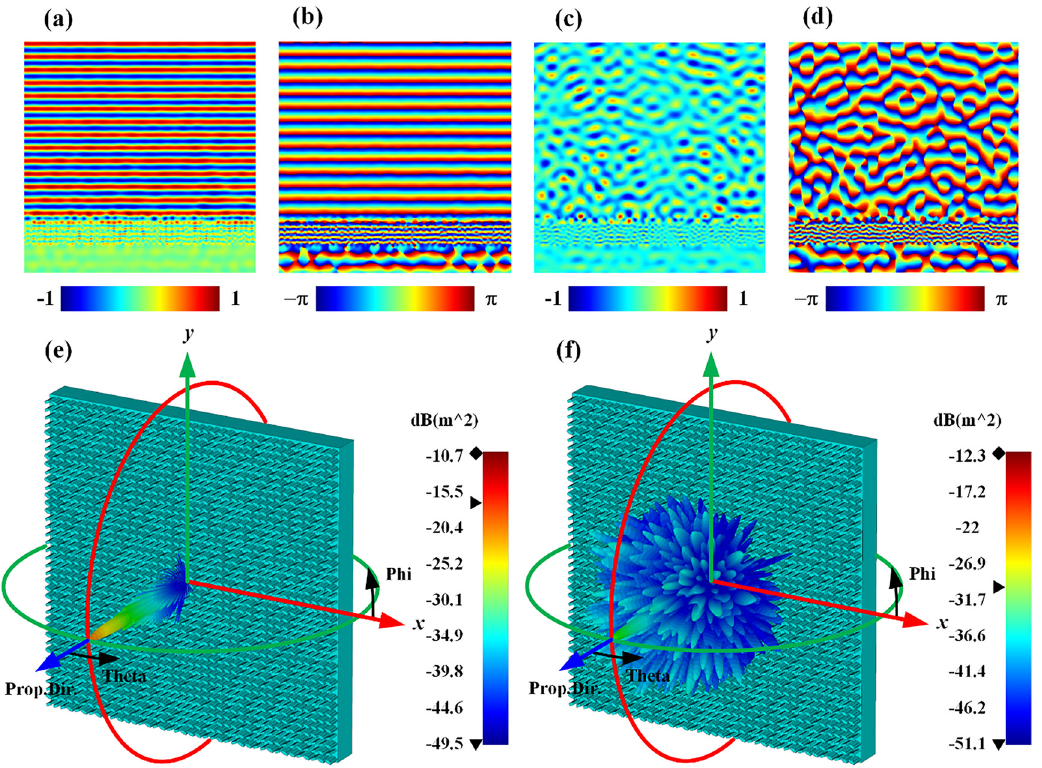
Figure 2: Simulated results of the metasurface-1. (a)and(b)Theexitamplitudesandphaseprofilesofthemetasurface-1undertheRCPincidence.(c)and(d)Thecorrespondingamplitudesand phase pro fi les under the LCP incidence. (e) and (f) Simulated 3D far- fi eld scattering patterns for the RCP and LCP